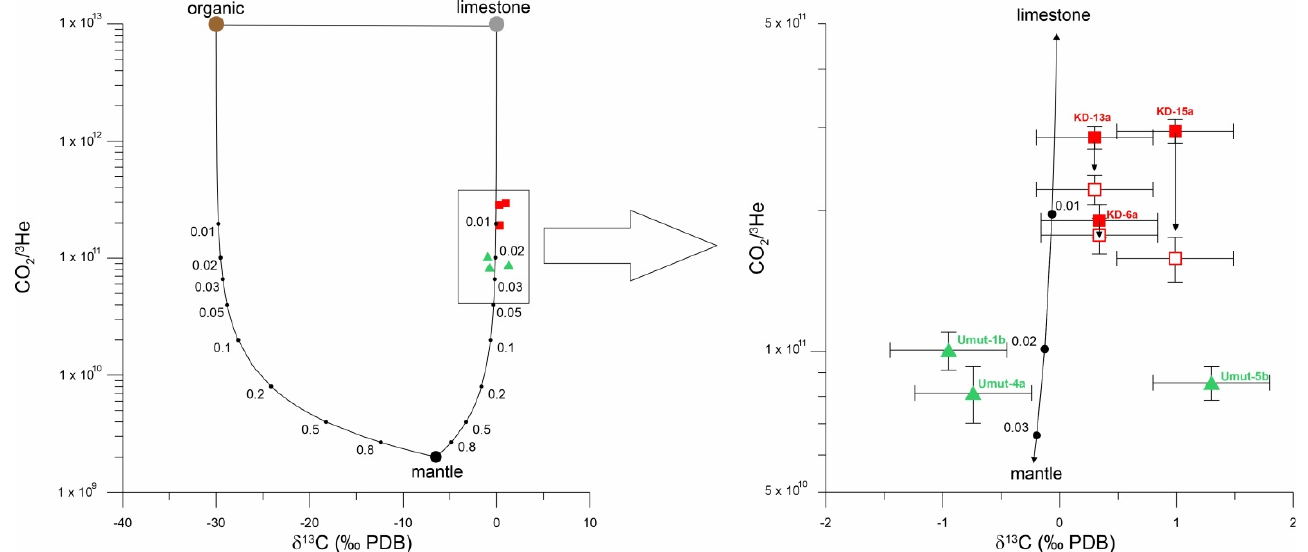
Figure 2. Diagram of CO 2 / 3 He (data from 29) vs. δ 13 C (CO 2 , ‰ PDB) including organic, limestone and magmatic endmembers (see text for values) from [56] and mixing hyperbolas. Kızıldere samples: red squares, Tekke Hamam samples: green triangles. Right site: close up showing Kızıldere samples corrected for He phase separation effects (open squares). See text for details.